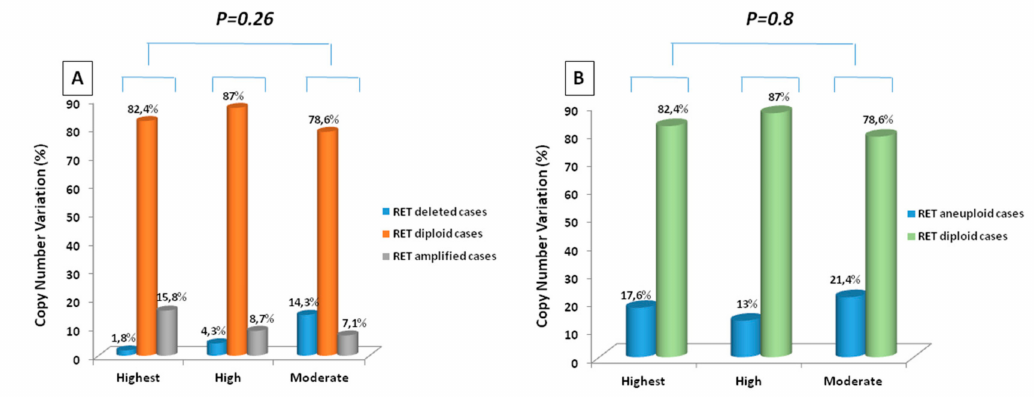
Figure 4. Comparison between the type of RET somatic mutation classified according to the ATA guidelines and the status of RET ploidy. ( A ) amplified and deleted cases are considered separately; ( B ) RET deleted and amplified cases (i.e., aneuploid cases) have been considered as a single category.